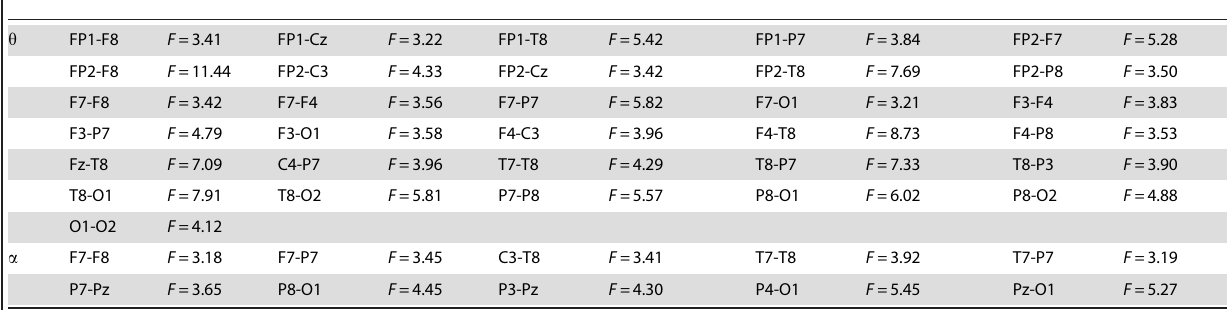
Table 1. Significant Results of F-test and Tukey Test of Correlation (p ,